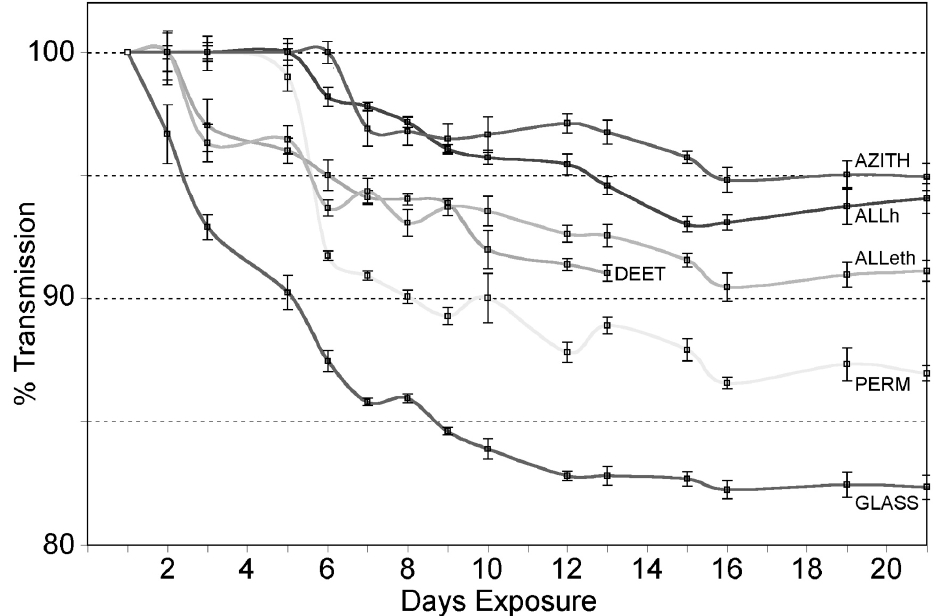
Figure 2. Percent light transmission over time. Light transmission in percent (mean ± S.D) through ( n = 10) sol–gel disks with immobilized antifouling agents as in Figure 1. Transmission LED light source, 6500 K. Test substrates were bathed in running seawater at the end of the SIO pier for 3 weeks. Data are normalized to 100% transmission at the start of the treatment period. The curve labeled GLASS shows non-treated glass microscope slides suspended alongside the sol–gel disks. The DEET treatment was terminated when the fixture holding the DEET sol–gel disks was